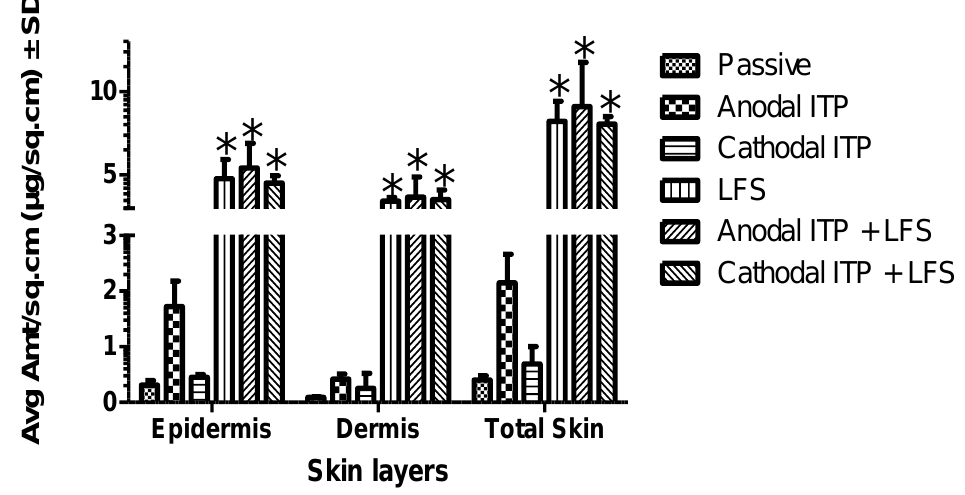
Figure 5. Levels of MTX in dermatomed human cadaver skin (* indicated statistical difference from the passive, anodal, and cathodal ITP, mean ± SD, n = 4, p < 0.05).